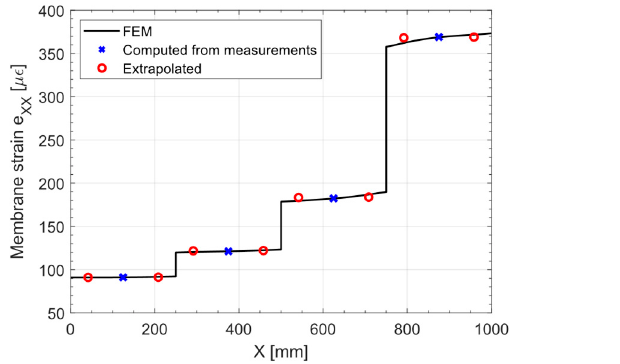
XX pre-extrapolation.